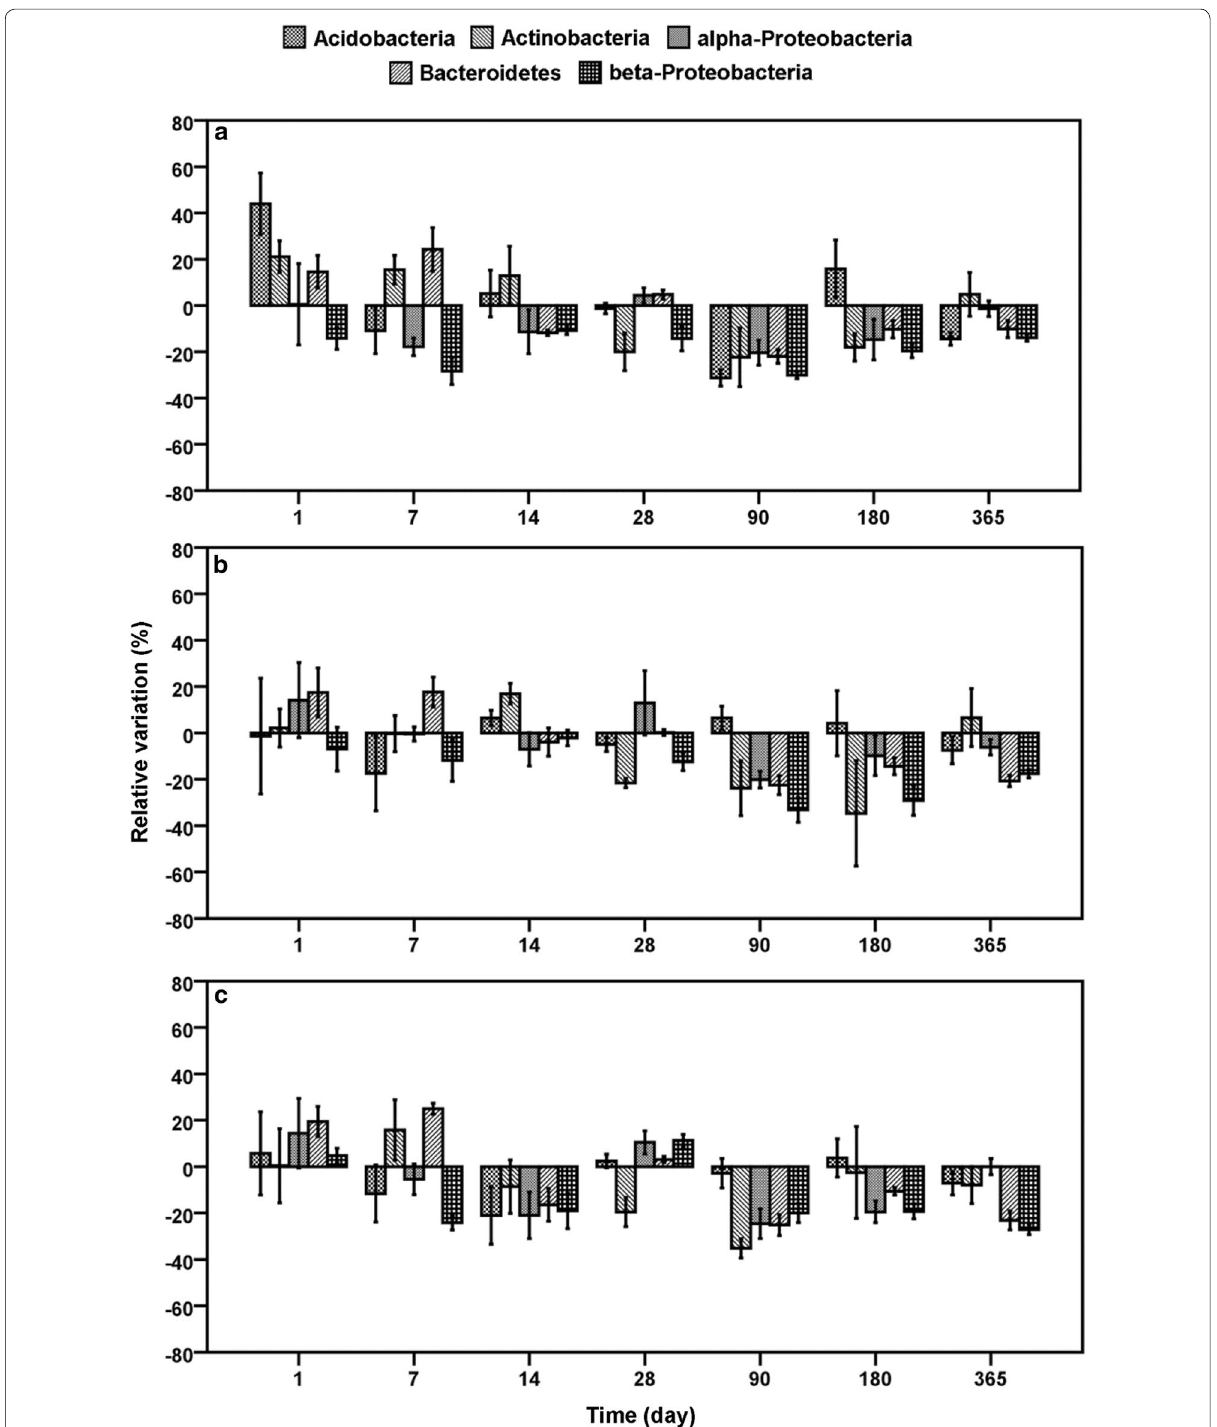
Fig. 1 Relative variations of Acidobacteria , Actinobacteria , alpha ‑ Proteobacteria , Bacteroidetes and beta ‑ Proteobacteria compared to untreated control related to time at different AgNP concentrations. a 0.01 mg AgNP/kg, b 0.10 mg AgNP/kg, c 1.00 mg